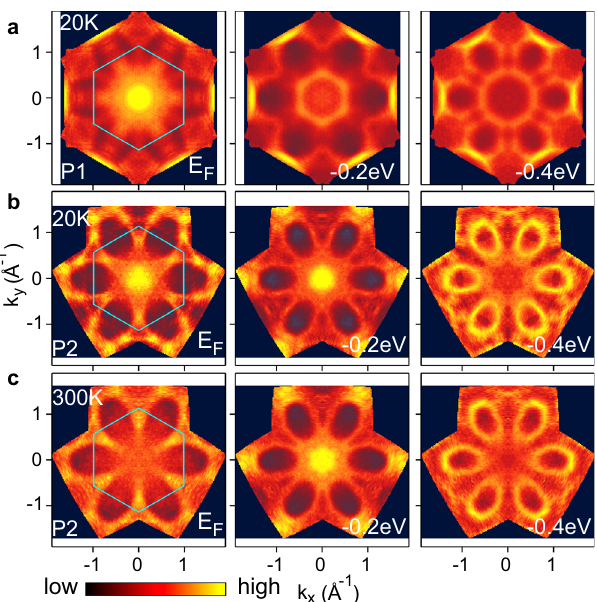
Fig. 4 Temperature evolution of the electronic structure. a ARPES spectra of P1 (top) and P2 (bottom) along (cid:1) Γ (cid:1) M at 20 and 300 K. b The temperature evolution of EDCs at (cid:1) Γ . The 4 f peaks for P2 are labeled individually. c Temperature-dependent EDCs divided by RC-FDD for P2. d Temperature evolution of the peak positions for P2.